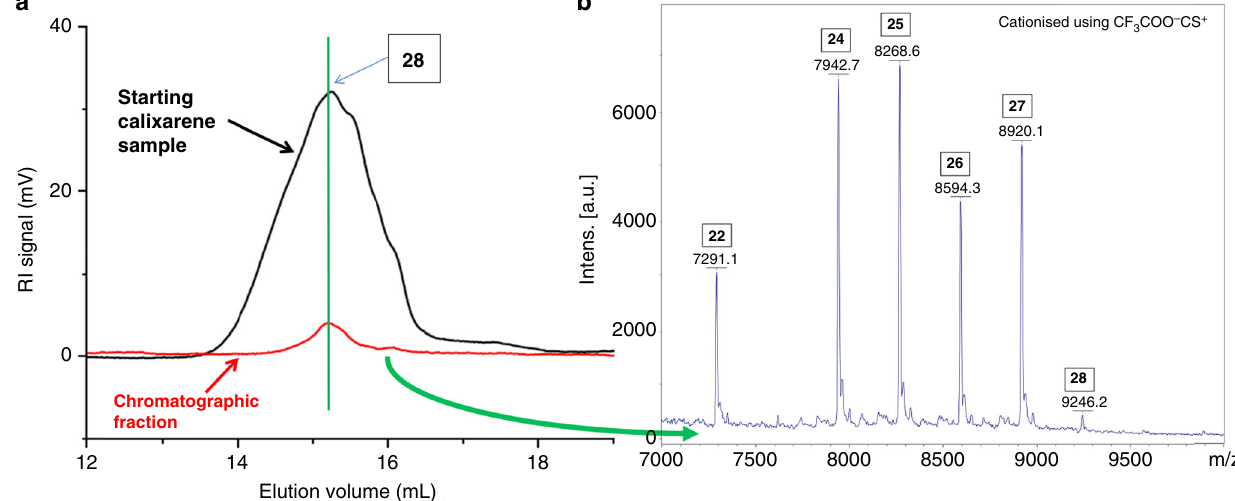
Fig. 6 Combined SEC a and MALDI-MS b analyses of a giant calixarene sample. PRU number shown in